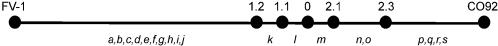
Phylogenetic relationships among the seven Y. pestis SNP genotypes identified in this study. Neighbor-joining tree was created using the data presented in Table 3 and MEGA2 software [23], and was rooted on genotype 0, as this genotype was assigned to the two outgroup isolates (see text). The position of the 19 SNPs (Table 1) are indicated below the tree. Individual genotypes or nodes were named based upon their position relative to genotype 0.